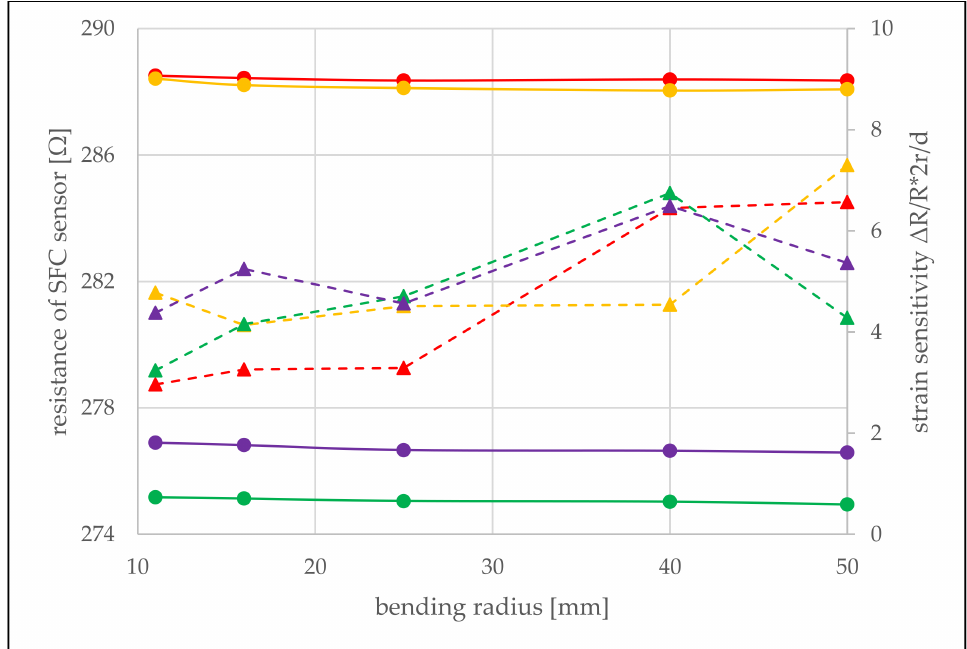
Figure 5. Resistance as a function of bending stress measured at 20.0 ◦ C (circles). Similar strain sensitivities around 5 (the values calculated from the measuring points are indicated by triangles connected by dashed lines) are obtained. The strong fluctuation of the strain sensitivity is due to the measurement inaccuracies with very small measured